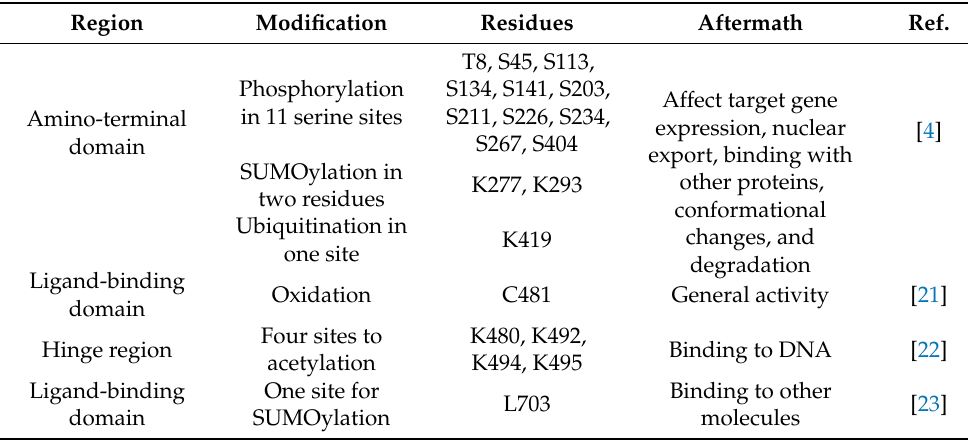
Table 1. Main post-translational modifications of